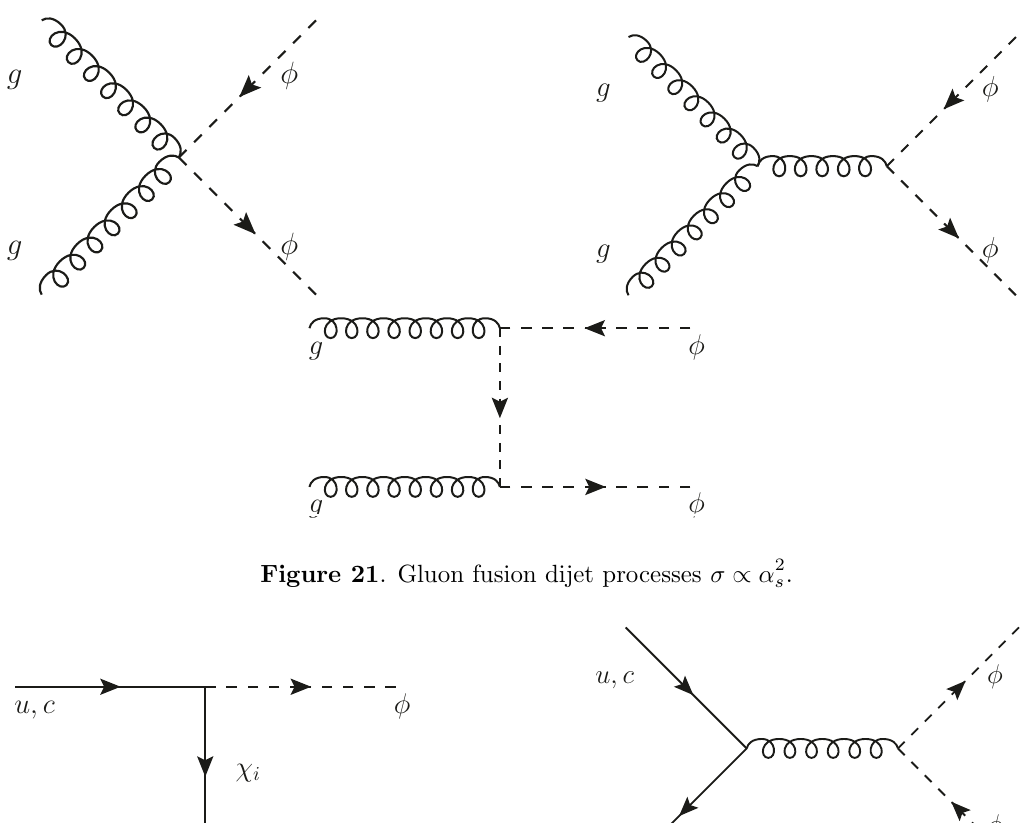
Figure 22 . The left (right) process has (cid:27) of the new couplings | for couplings which are large enough to be excluded it is usually the left diagram which